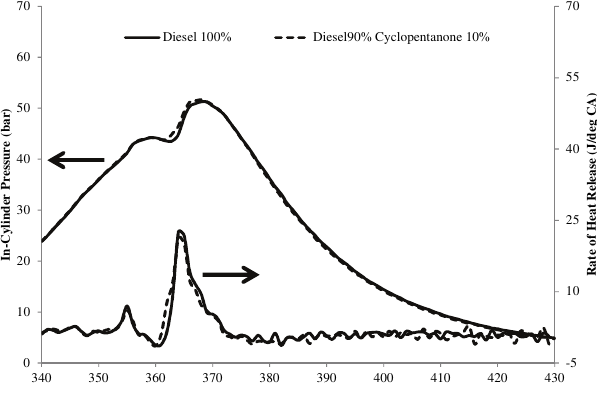
Table 2. Physical and chemical properties of tested fuels Fig. 7. Effect of tested fuels on combustion characteristics Use of Cyclopentanone-Diesel blends as a fuel has ef- fect on the gaseous emissions coming from the exhaust. Figure 8 show the CO and THC engine-out emissions for the investigated fuels. It can be concluded that both CO and THC for the tested cyclopentanone blend were higher com- pared with diesel combustion in engine. Also Figure 9 indi- cates that ethylene, ethane and methane emissions are high- er than those from diesel